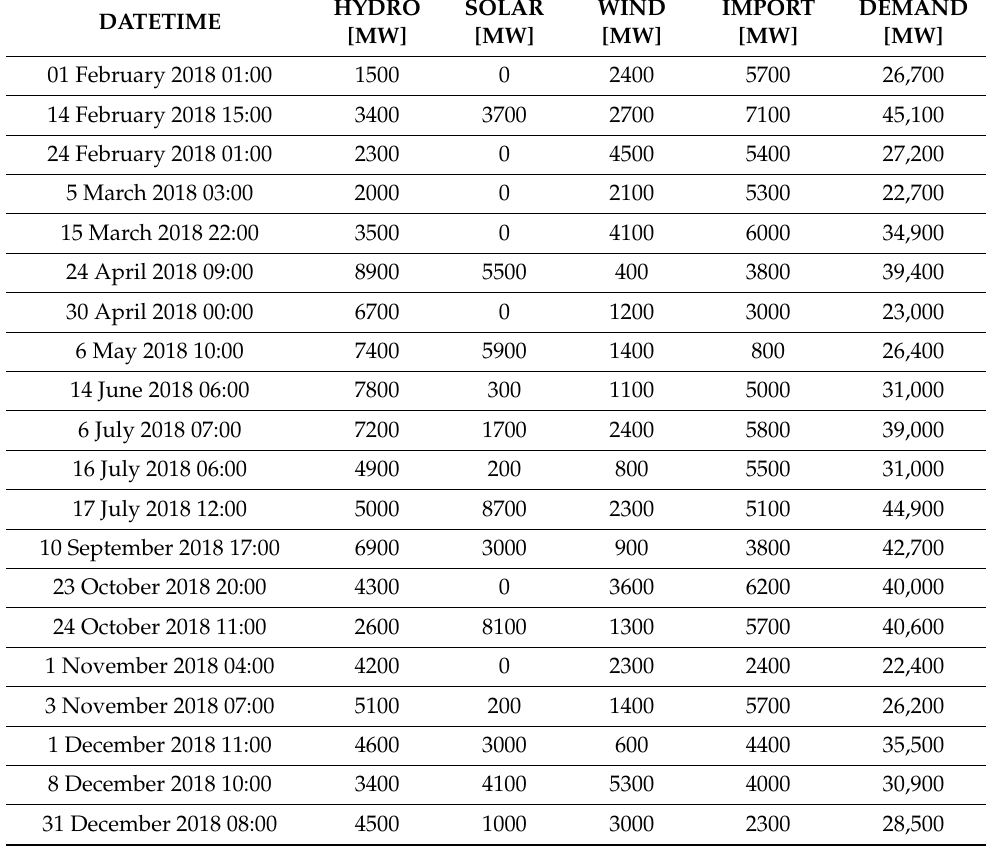
Table 3. Selected 2018 base cases.